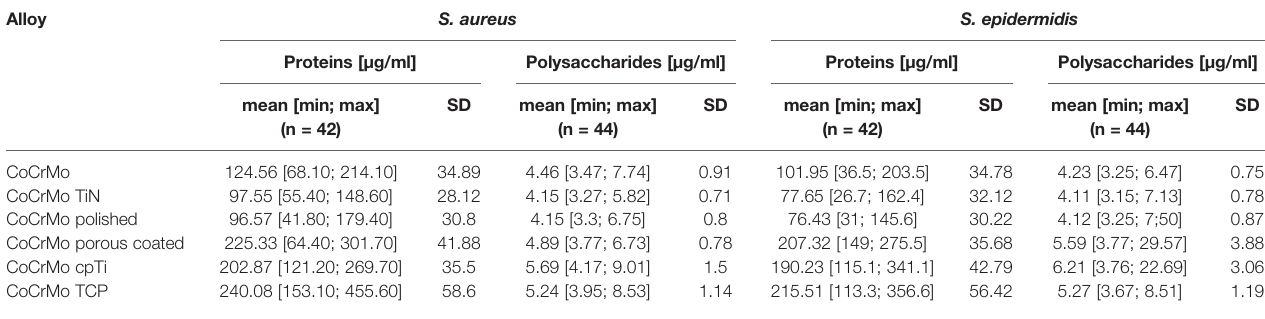
TABLE 2 | Mean, minimum and maximum values and standard deviations (SD; 95% con fi dence interval) of protein and polysaccharide measurements. Alloy S.